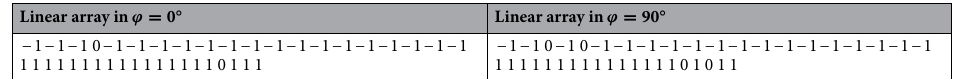
Linear array in ϕ = 0 ◦ Linear array in ϕ = 90